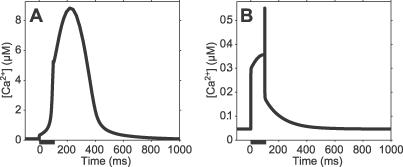
Time Course of [Ca2+]spine
[Ca2+]spine was monitored during and after 100 ms of somatic depolarization (−70 mV to 0 mV, bold bars) in the presence (A) and absence (B) of a conjunctive stimulus to the synapse at time = 0 ms.